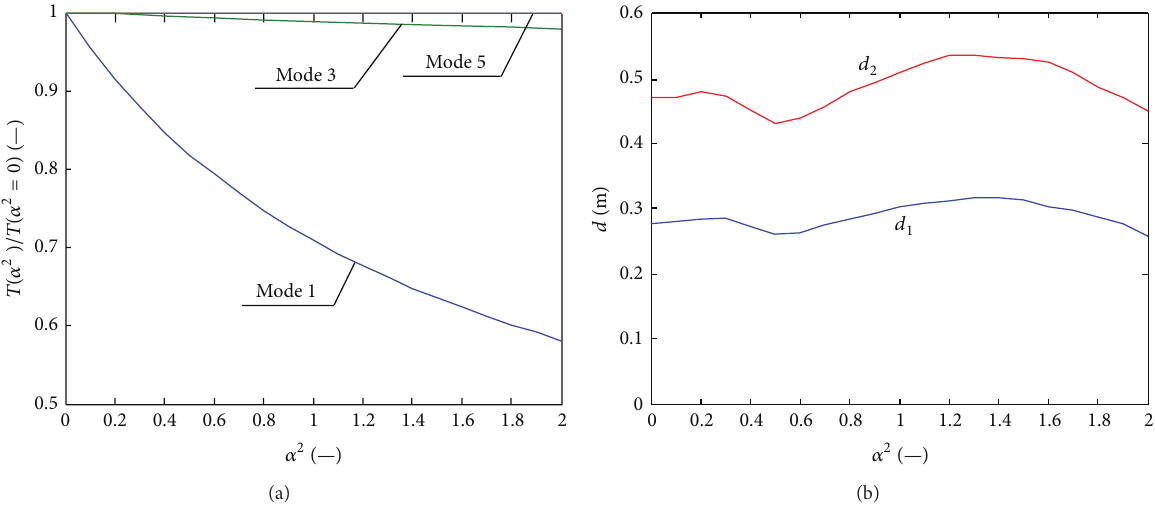
Figure 6: (a) Variation with 𝛼 2 of normalized transverse period 𝑇(𝛼 2 )/𝑇(𝛼 2 = 0) ; (b) variation with 𝛼 2 of displacement demand of the deck in correspondence with the external piers ( 𝑑 1 ) and the central pier ( 𝑑 2